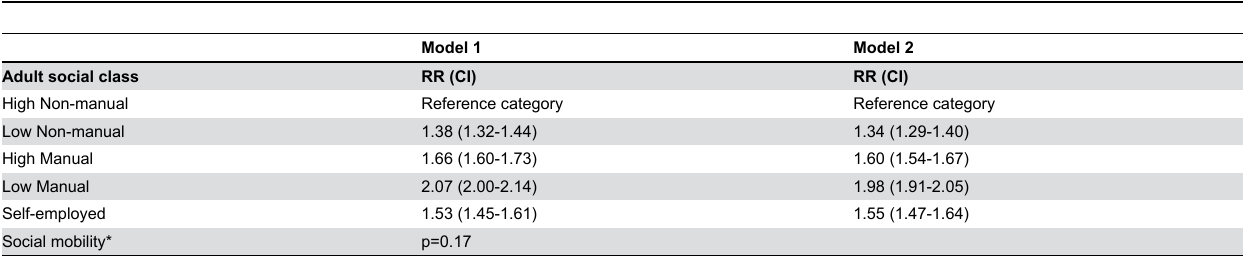
Table 2. Relative risk (RR) of psychiatric disorder and two-sided 95% confidence intervals (CI) comparing subjects with different adult social